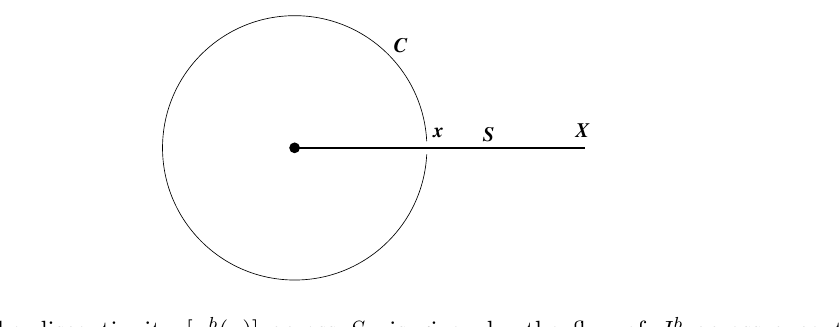
Figure 2 . The discontinuity [ (cid:31) b ( x )] across S n is given by the (cid:13)ux of J b across a contour C surrounding x n